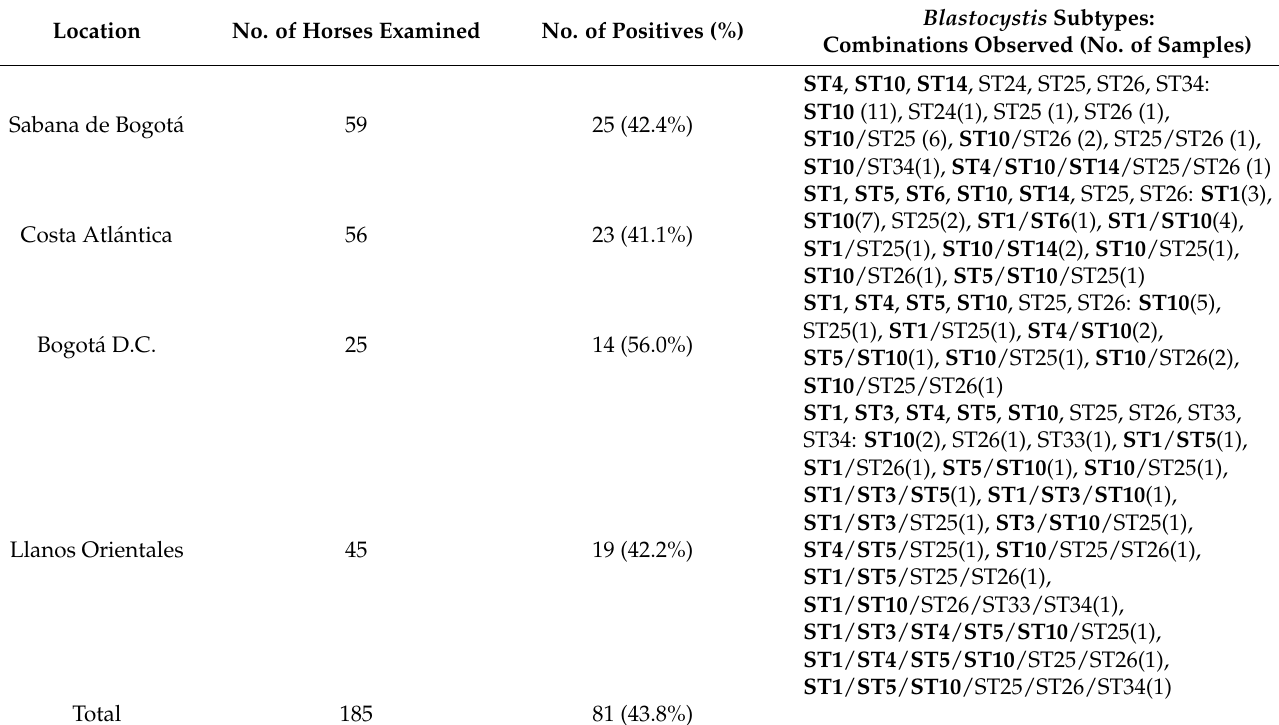
Table 2. Number of horses examined, number of horses positive, prevalence (%), and subtypes of Blastocystis by location. Subtypes in bold denote those previously identified in